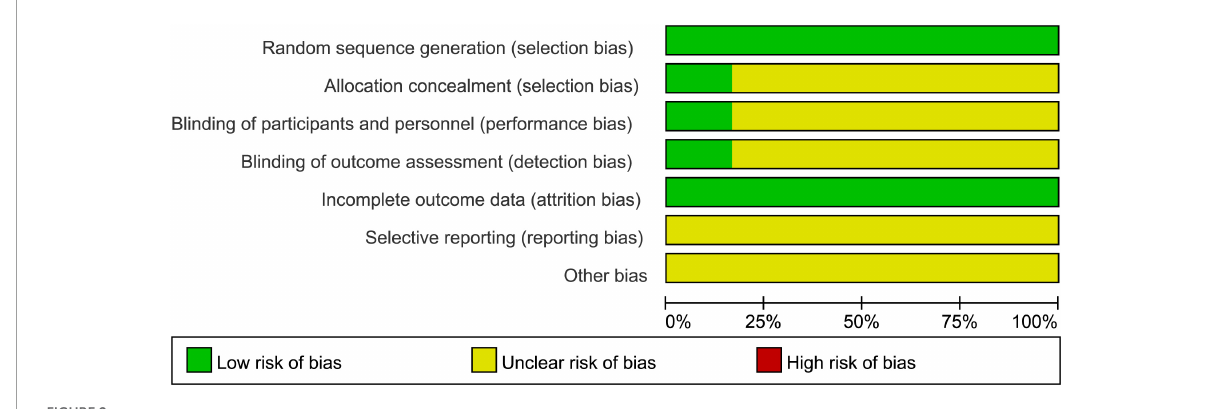
FIGURE2 Risk of bias of included studies.